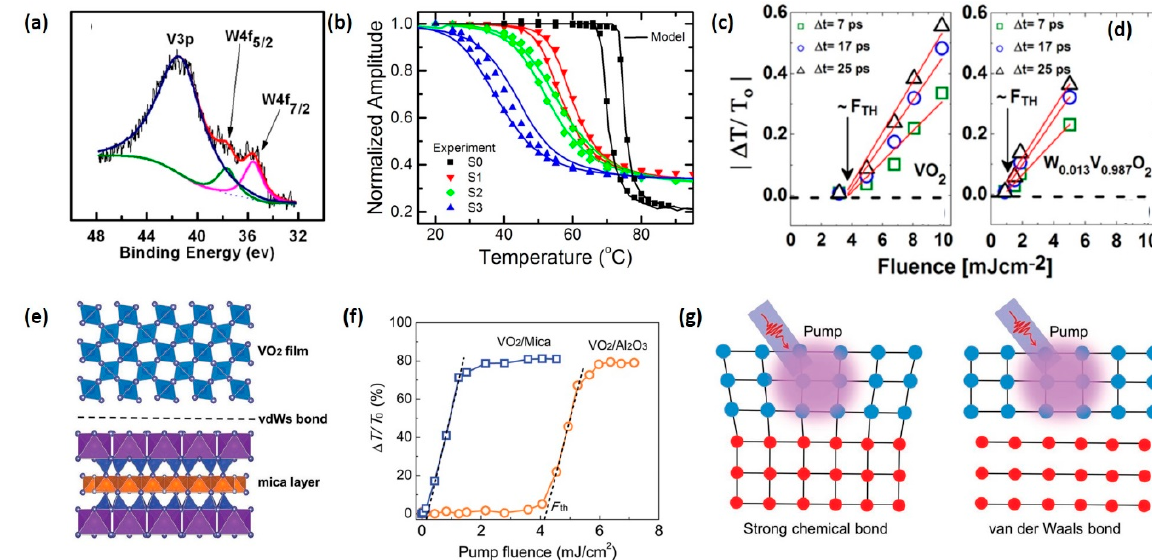
Figure 8. The influence of fabrication techniques. ( a ) XPS pattern of W-doped VO 2 film. Reproduced from [101], with permission from American Institute of Physics 2015. ( b ) Normalized THz transmission (symbols) as a function of temperature for W x V 1-x O 2 /sapphire samples S0, S1, S2 and S3 (x = 0, 1.47%, 1.59% and 1.73% respectively). Reproduced from [91], with permission from American Institute of Physics 2014. ( c , d ) Dependence of THz transient transmission variation on excitation fluence at different delay times ( Δ t) of 7 ps, 17 ps and 25 ps for ( c ) VO 2 and ( d ) W 0 . 013 V 0 . 987 O 2 films, respectively. Reproduced from [128], with permission from American Institute of Physics 2017. ( e ) Schematics of Van der Waals (vdW) heteroepitaxial VO 2 film deposited on ultrathin mica substrate. ( f ) Pump fluence dependence of differential transmission ( Δ T/T 0 ) signals of VO 2 /mica and VO 2 /m-sapphire films at 1 THz. ( g ) Schematics of laser-induced lattice changes of heteroepitaxial VO 2 films on substrates with strong chemical bonding (covalent or ionic) and vdW bonding. Reproduced from [129], with permission from WILEY-VCH.